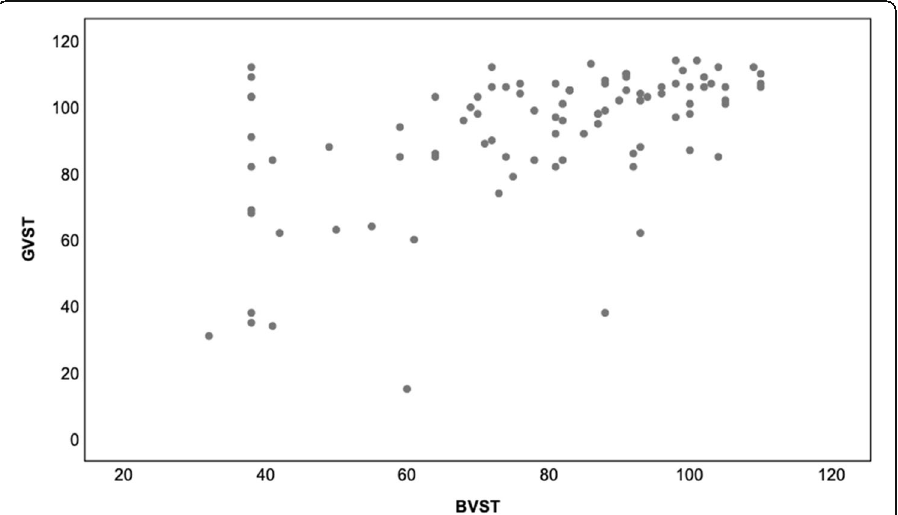
Fig. 2 comparison of GVST and BVST